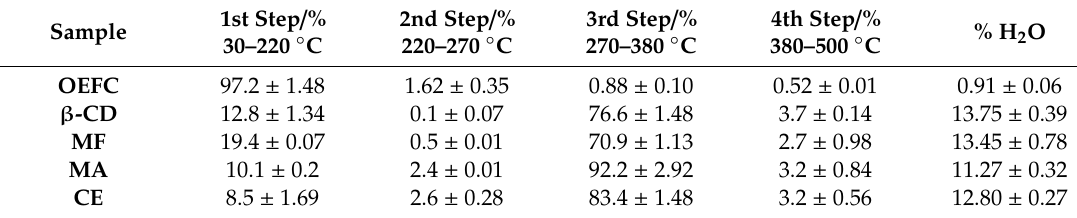
Table 1. Mass loss percentages obtained by thermogravimetry / derivative thermogravimetry and Karl Fisher titration from the OEFC ( Croton rhamnifolioides essential oil), β -CD ( β cyclodextrin), MF(physical mixture), MA (malaxage) and CE (co-evaporation)